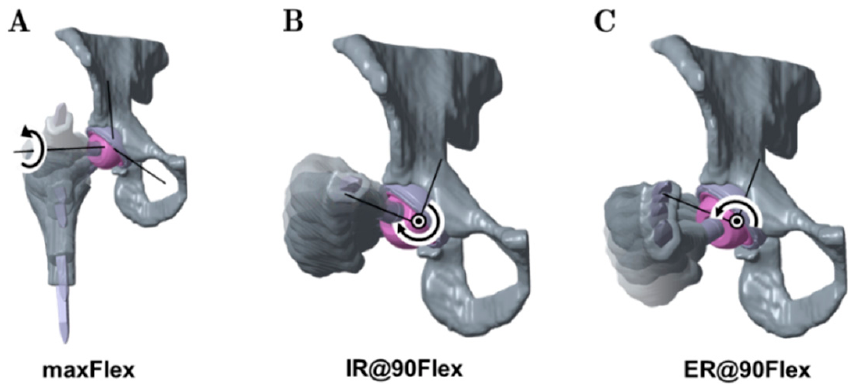
Figure 3. Depiction of the analyzed movements considered in the ROM analyses: maximum flexion starting from neutral (maxFlex) ( A ), internal rotation at 90° flexion (IR@90Flex) ( B ), and external rotation at 90° flexion (ER@90Flex) ( C ).